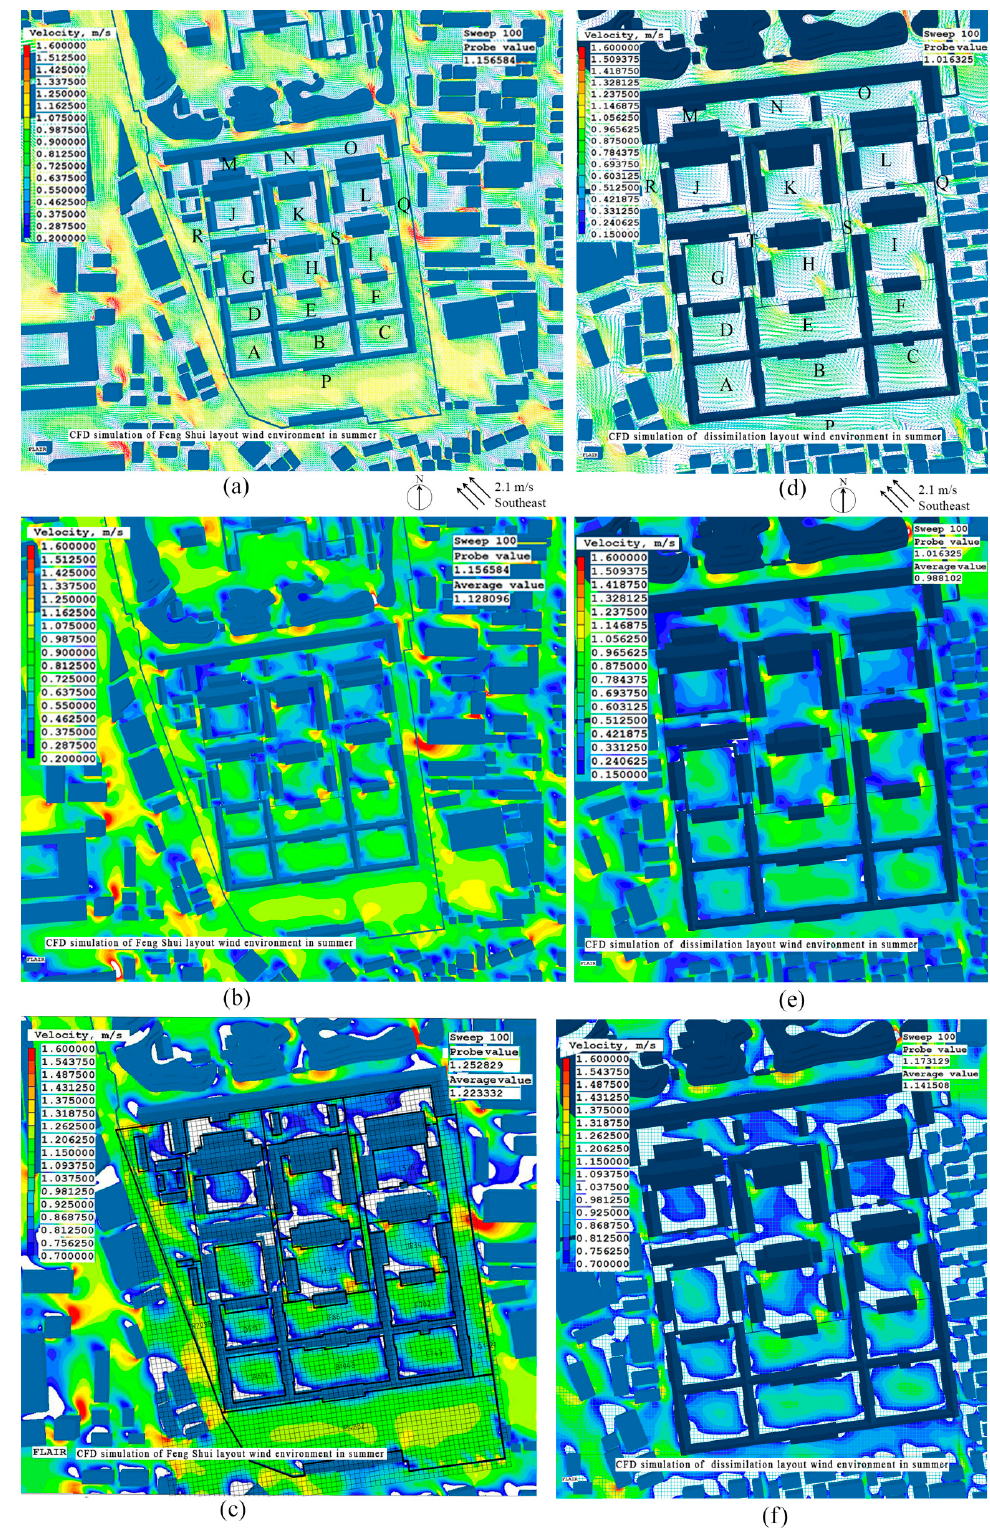
Figure 7. ( a ) Wind speed vector chart of feng shui layout. ( b ) Wind speed cloud chart of feng shui layout. ( c ) Comfortable wind speed zone cloud chart of feng shui layout. ( d ) Wind speed vector chart of dissimilation layout. ( e ) Wind speed cloud chart of dissimilation layout. ( f ) Comfortable wind speed zone cloud chart of dissimilation layout. The figures were obtained by CFD